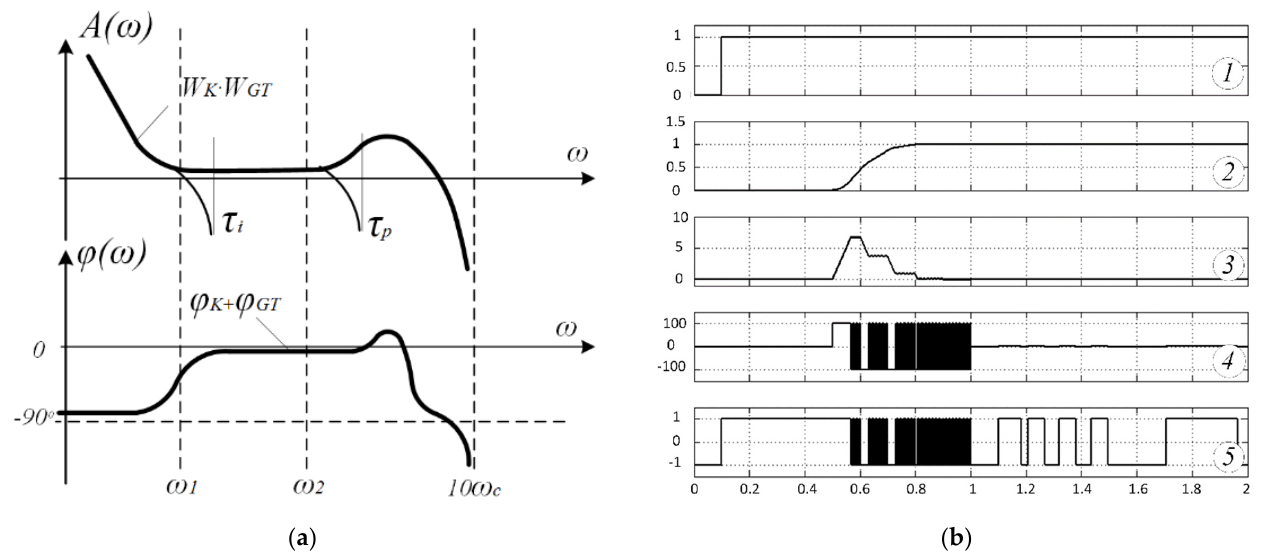
Figure 12. Logarithmic amplitude–frequency characteristics of VSS ( a ) and transient processes in the model with changed time delays while maintaining stability ( b ). 1 Reference signal. 2 Adjustable value. 3 Derivative. 4 Derivative signal after a discrete link. 5 Relay element output.